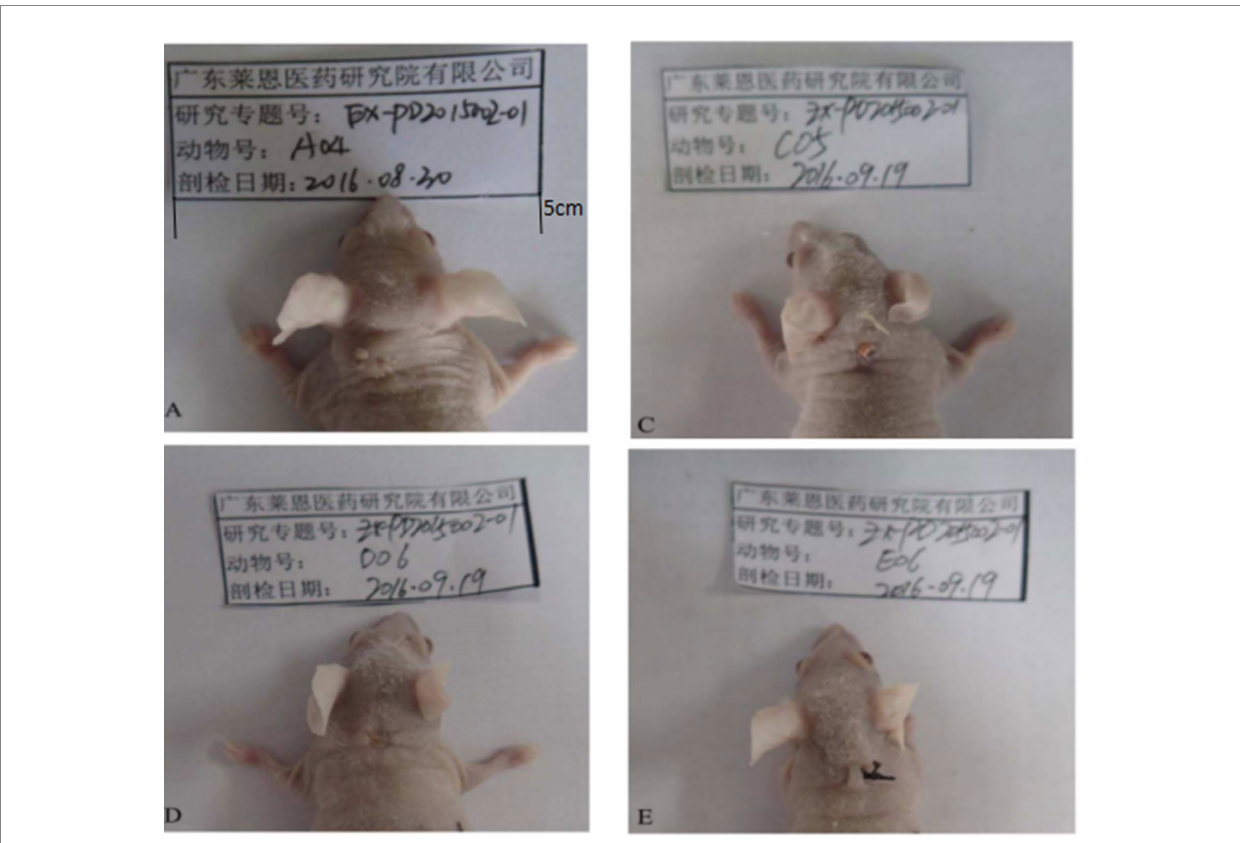
FIGURE 3 Changes of transplanted warts after 14 days of administration. A is the control group. From A , it can be seen that the warts were still growing and new small warts were growing out. C was the low-dose group. From C , the growth of the wart body was inhibited, and the wart body was obviously shrinking and smaller. D was the medium-dose group. From D , the wart body had basically fallen off. E was the high-dose group. In E , compared with A , the wart was smaller, no new warts grow